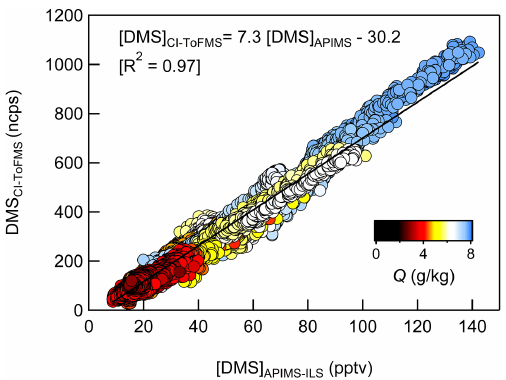
Figure 11. Regression of background corrected, benzene normal- ized DMS counts with DMS concentrations measured by APIMS- ILS. Regression analysis indicates a campaign-average CI-ToFMS sensitivity of 6.9ncpsppt − 1 .